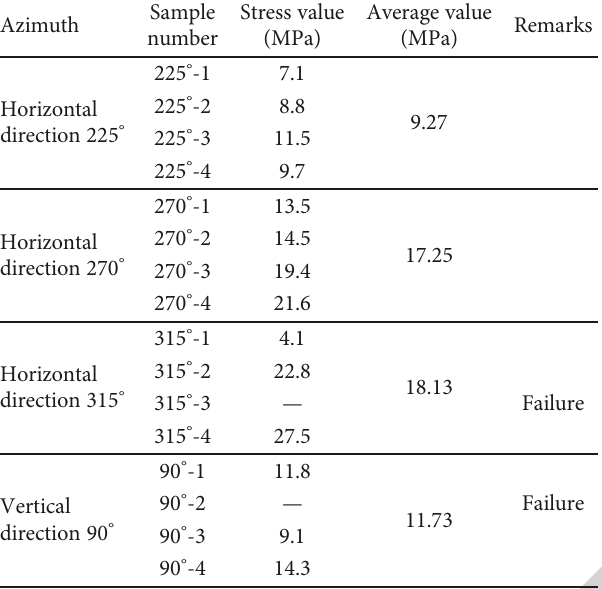
Table 3: Kaiser point stress value of rock sample.